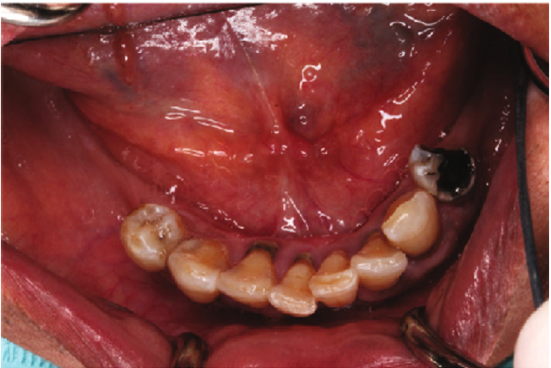
Figure 1: Preoperative frontal view.